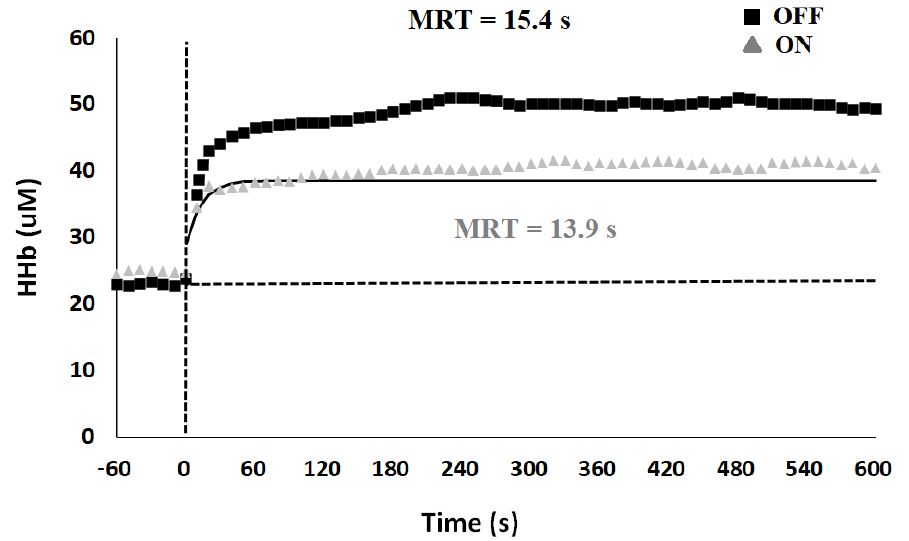
Figure 3. Characteristics of the two-component exponential model describing deoxyhemoglobin (HHb) during the on-transient of heavy intensity. Data refer to transition (at time 0, vertical dashed line) from unloaded pedaling to constant-load exercise during OFF ( ■ ) and ON ( ▲ ) experimental condition. Data points are average values calculated over 1 s. Data obtained during the first 20 s of the transition were excluded from analysis. Table 3. Deoxygenated hemoglobin on-kinetics parameters from unloaded pedaling to constant-load exercise across conditions (OFF; ON).